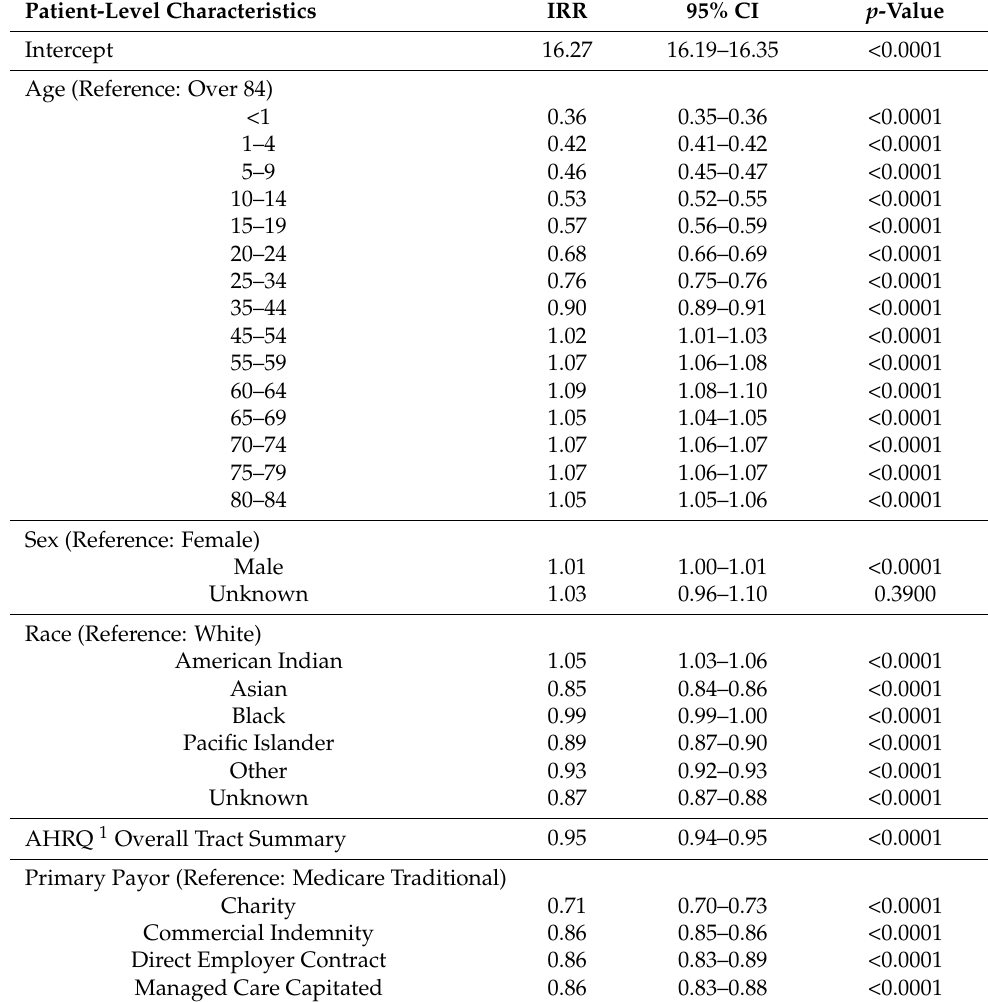
Table 2. Poisson additive model incidence rate ratios (IRRs) and corresponding 95% confidence intervals (CIs), as well as p -values, for patient